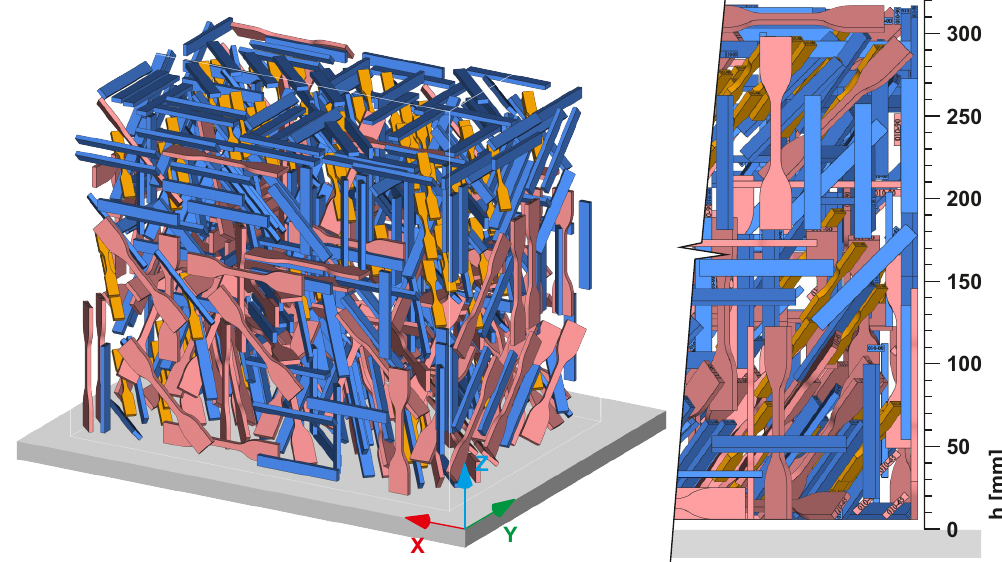
Figure 8. Overview of print batch with all the specified polypropylene